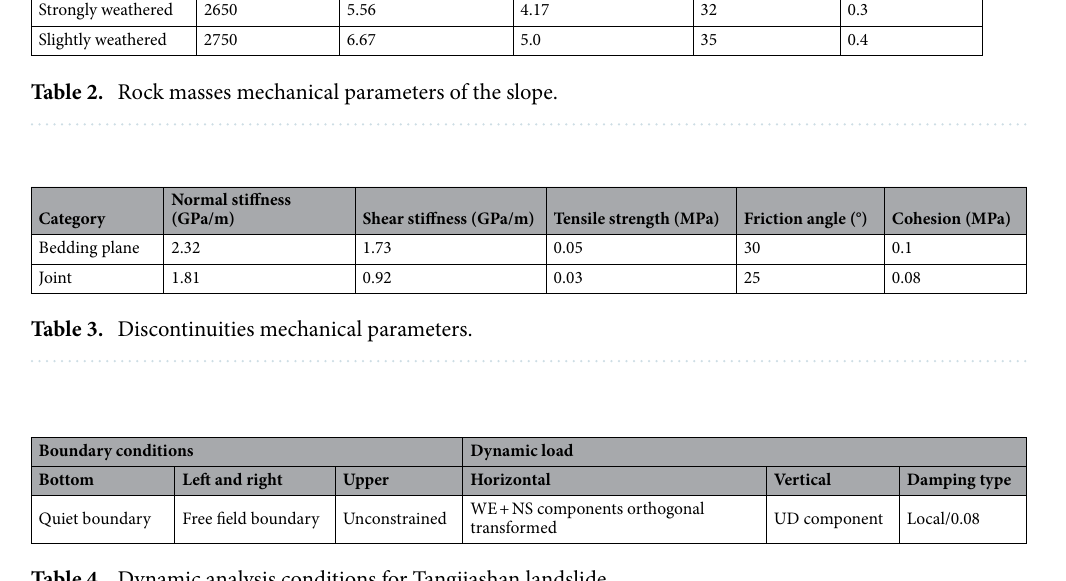
Table 4. Dynamic analysis conditions for Tangjiashan